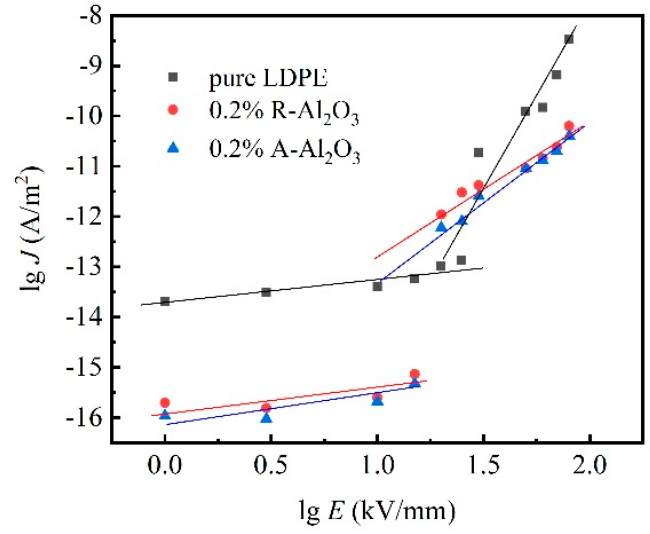
Figure 6. Current densities of pure LDPE, R-Al 2 O 3 /LDPE and A-Al 2 O 3 /LDPE depended on electrical strength.